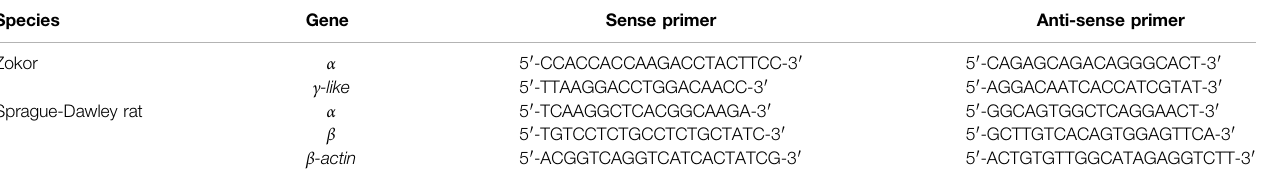
TABLE 3 | The primers of α , β , γ -like , and β -actin used in the present study.